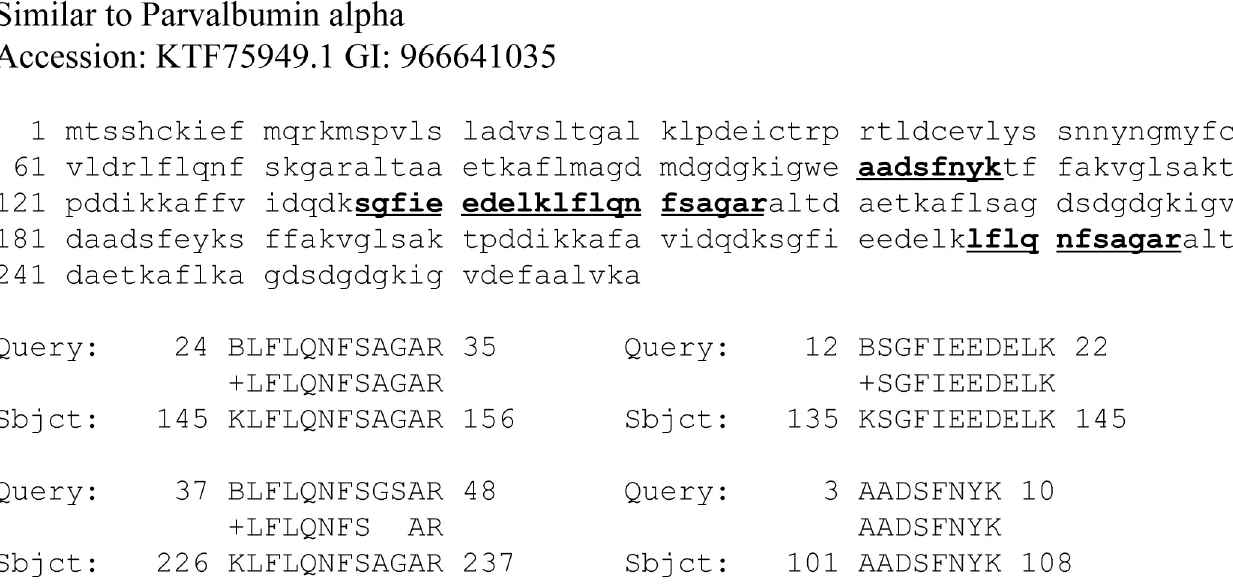
Fig 3. Parvalbumin peptides detected in #3258 basal crust are matched to C . carpio sequence by MS BLAST. “Query” includes sequences of peptides identified in the sample; “Sbjct”—sequences of corresponding peptides matched to C . carpio protein (acc no KTF75949.1).